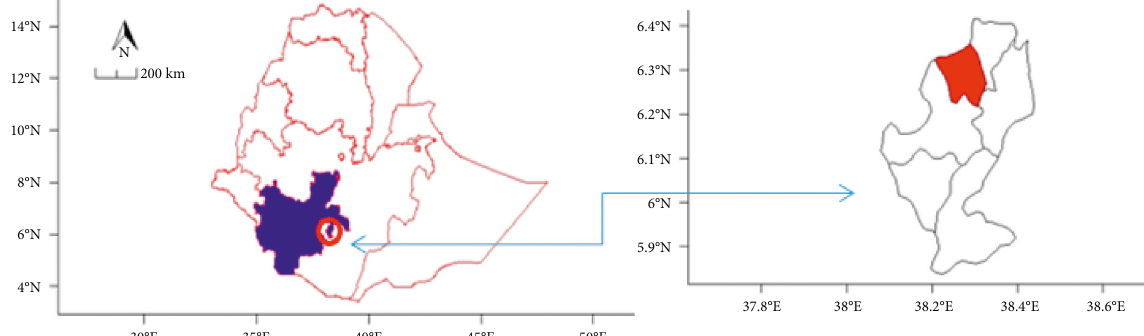
Figure 1: Research site (blue color � south region; red color � Wonago